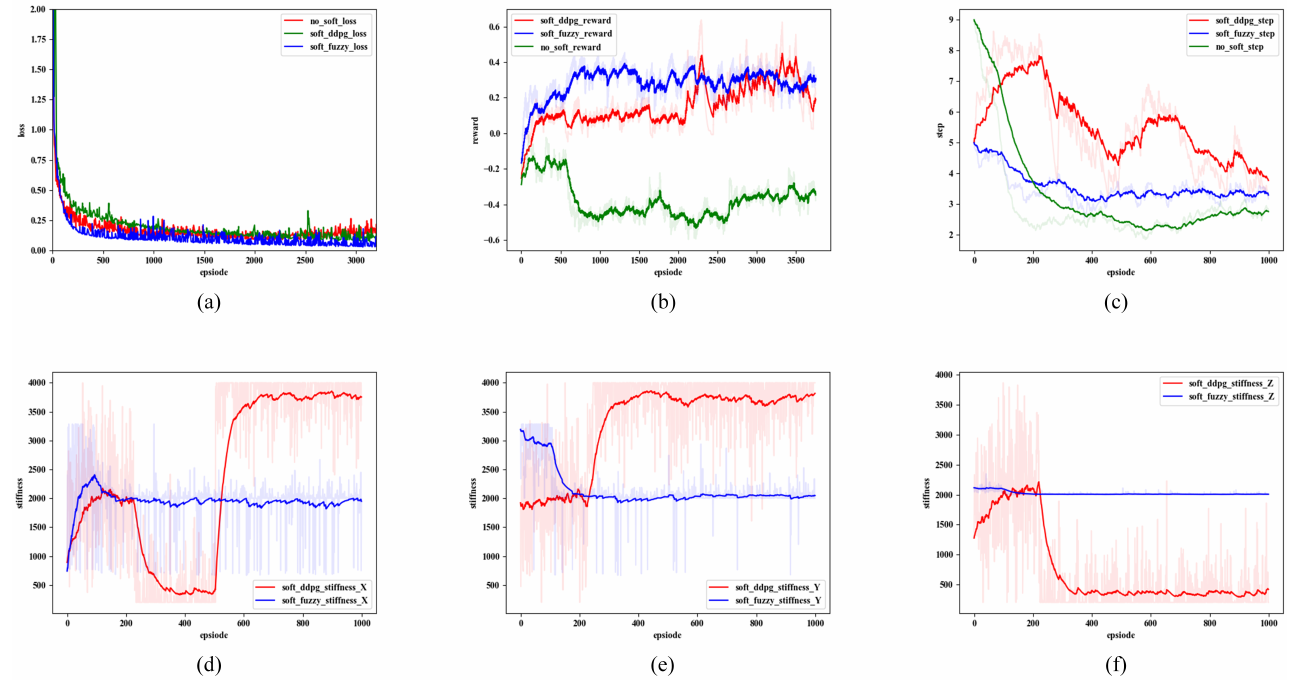
Figure 10. The assembly strategy learning process: ( a ) loss value change during training; ( b ) reward value change during training; ( c ) step value change during training; ( d – f ) represent the changes of the impedance values in the x , y , and z directions when the impedance parameters are adjusted by the learning method and the fuzzy logic method,